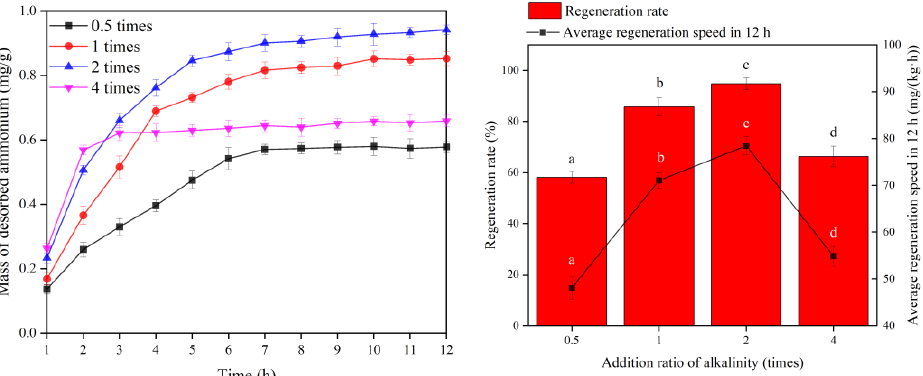
Figure 4. Biological regeneration performance of bio-ceramsite in different alkalinity ratios. Vertical bars represent ± SD of the means ( n = 3). In bar chart, the different superscript letters mean significantly different (Tukey’s post hoc test, p < 0.05).